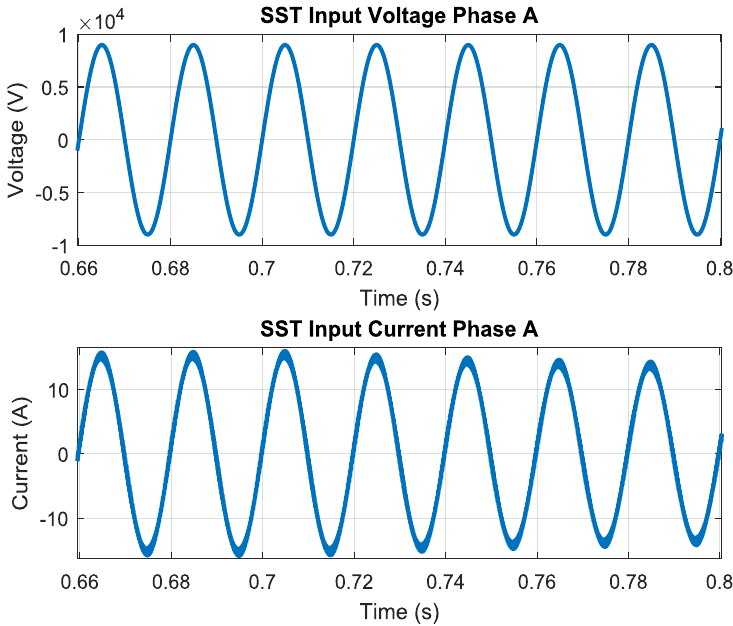
Figure 27. Result displaying that phase A voltage and current are in phase. Appl. Sci. 2019 , 9 , x FOR PEER REVIEW